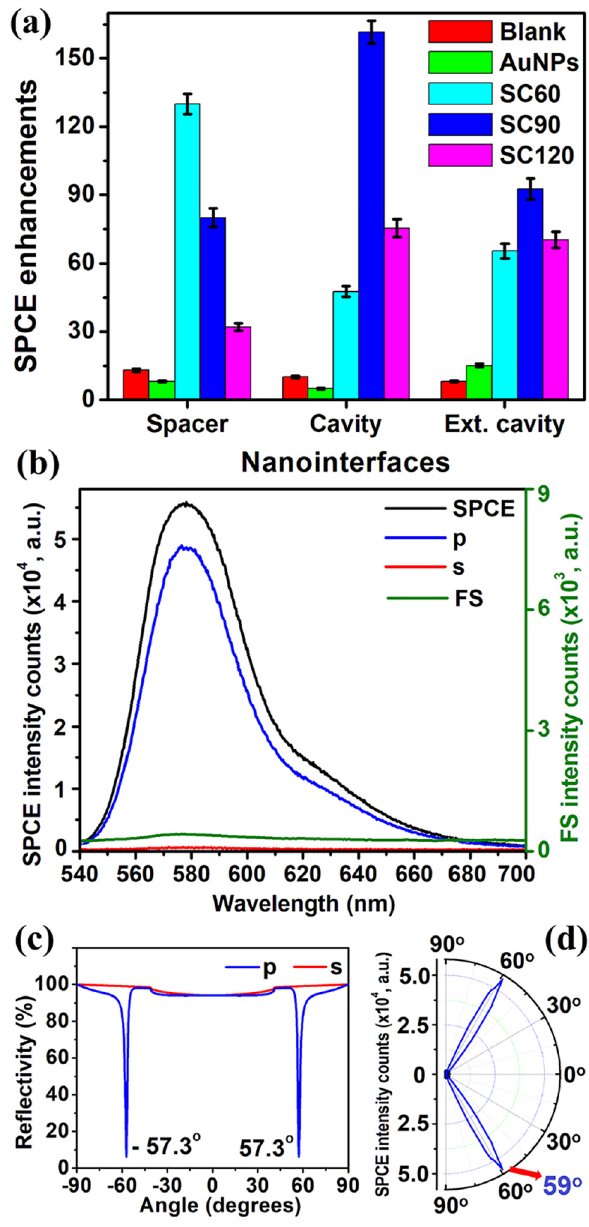
Figure 3: (a) SPCE enhancements, (b) SPCE, Free Space (FS), p -polarized ( p ) and s -polarized ( s ) emission pro fi les for the sample that presented maximum emission enhancements in (a) (that is